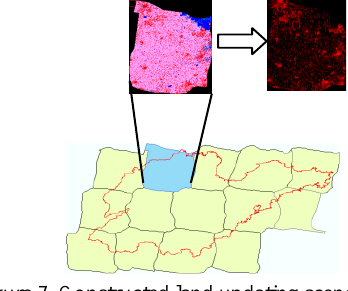
Figure 7. Constructed land updating scene by scene